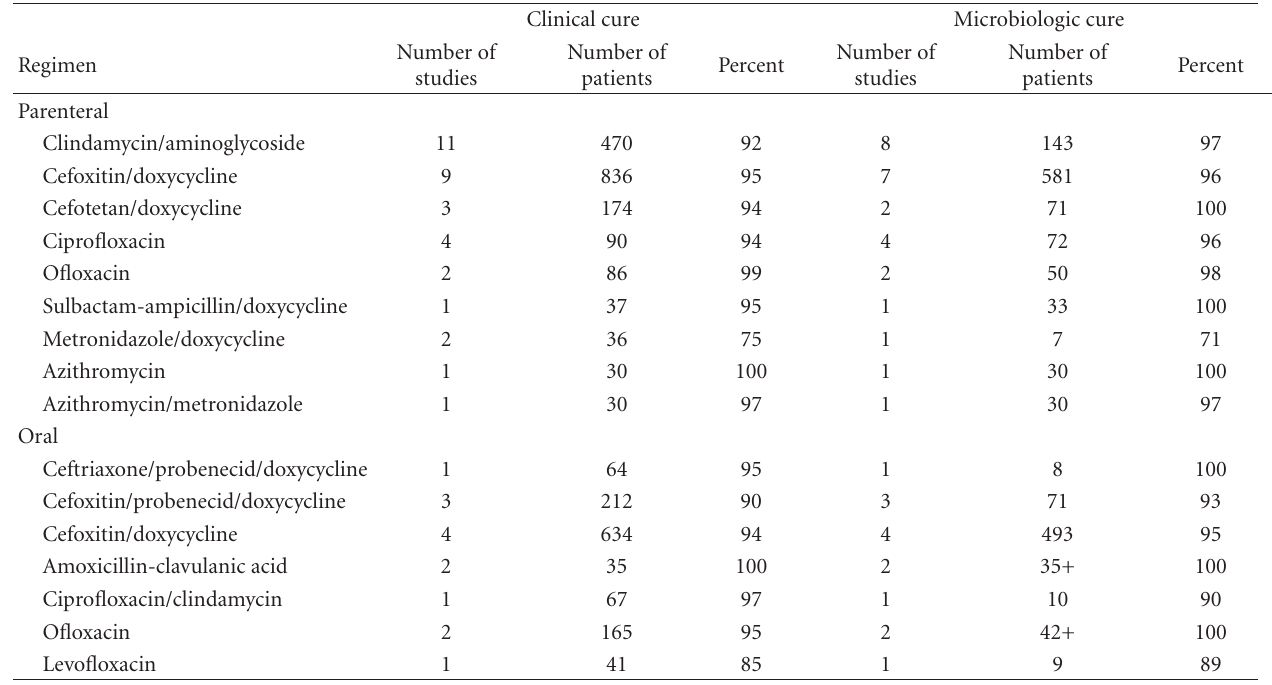
Table 4: Clinical and microbiologic cure rates for pelvic inflammatory disease treatment